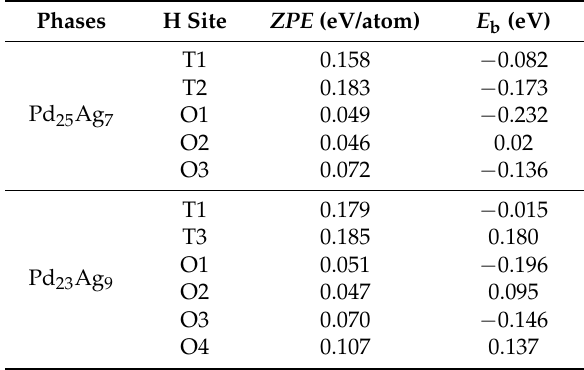
Figure 4. Schematic illustrations of various interstitial sites of ( a ) Pd 25 Ag 7 (Ag Pd ) and ( b ) Pd 23 Ag 9 (Pd Ag ). The largest gray, second largest green, and third largest red balls represent Ag, Pd, and H atoms, respectively. Table 3. Zero-point energy of hydrogen ( ZPE ) and binding energies ( E b ) of the Pd 25 Ag 7 and Pd 23 Ag 9 phases.